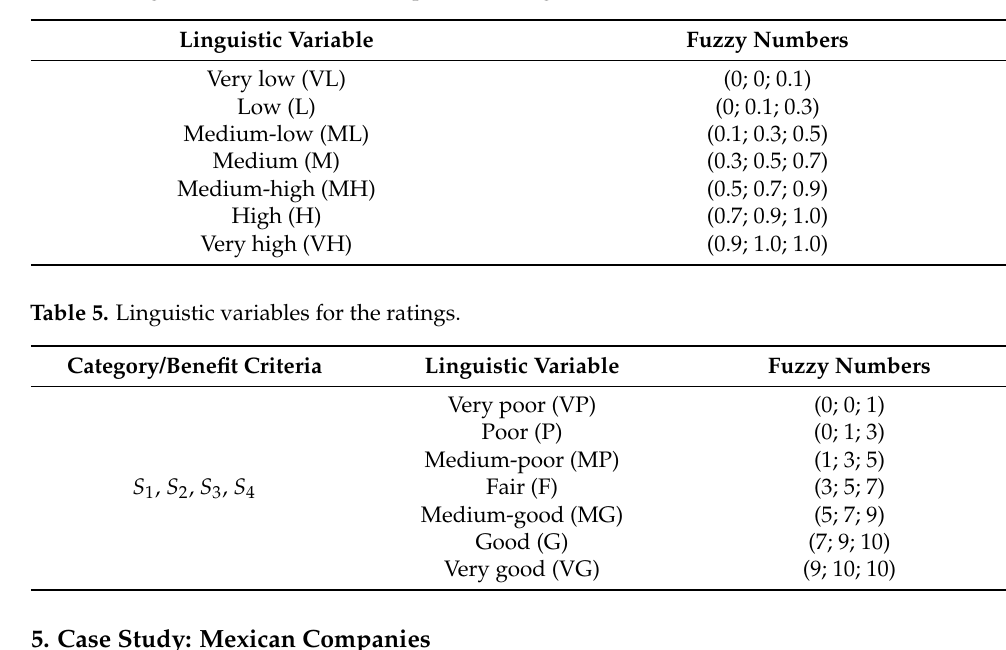
Table 4. Linguistic variables for the importance weight of each criterion.